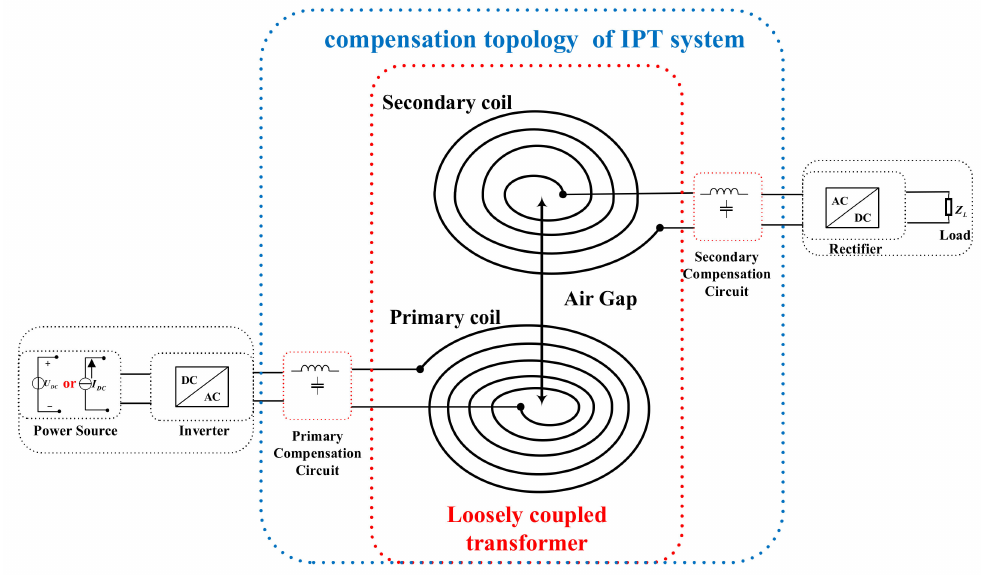
Figure 1. Schematic diagram of a typical inductive power transfer (IPT)